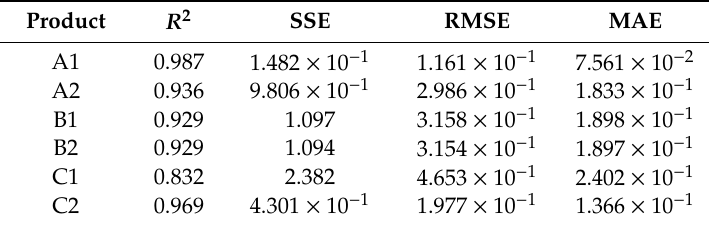
Table 4. Statistical parameters generated by GastroPlus ™ for each predicted plasma concentration-time